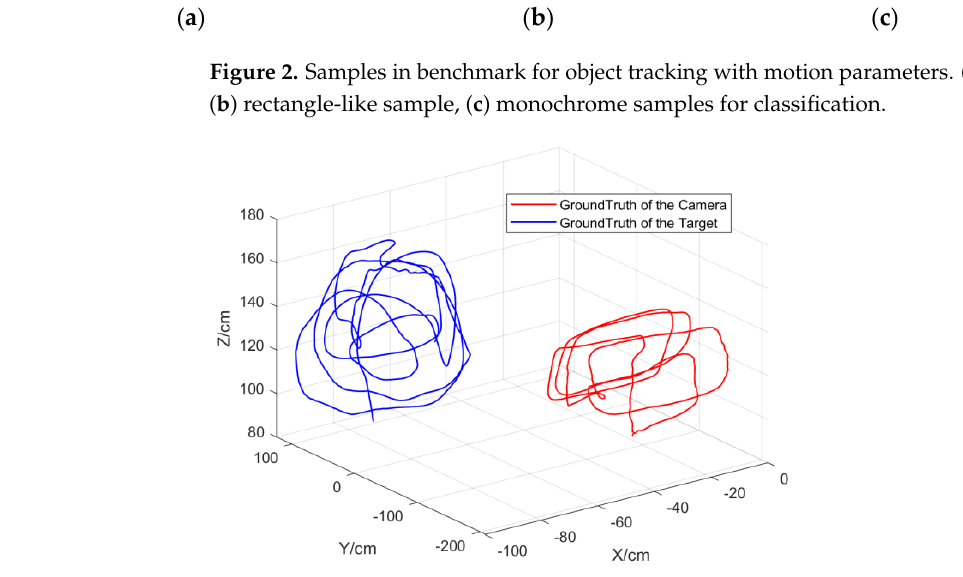
Figure 3. The trajectory of the target and the camera obtained by the motion − capture system.